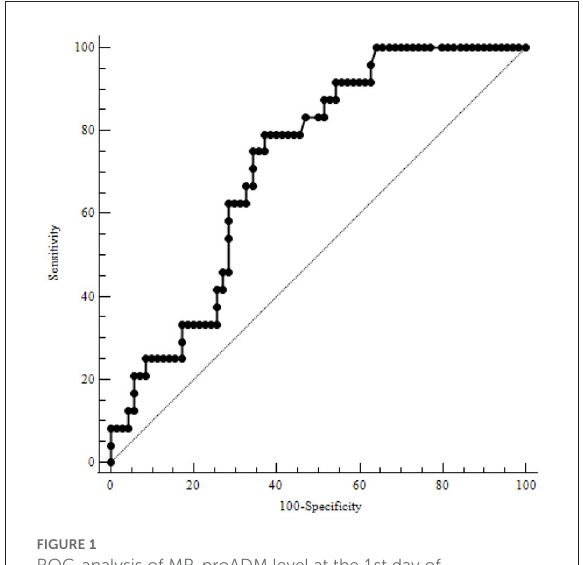
FIGURE1 ROC-analysis of MR-proADM level at the 1st day of hospitalization. MR-proADM—mid-regional pro-adrenomedullin.